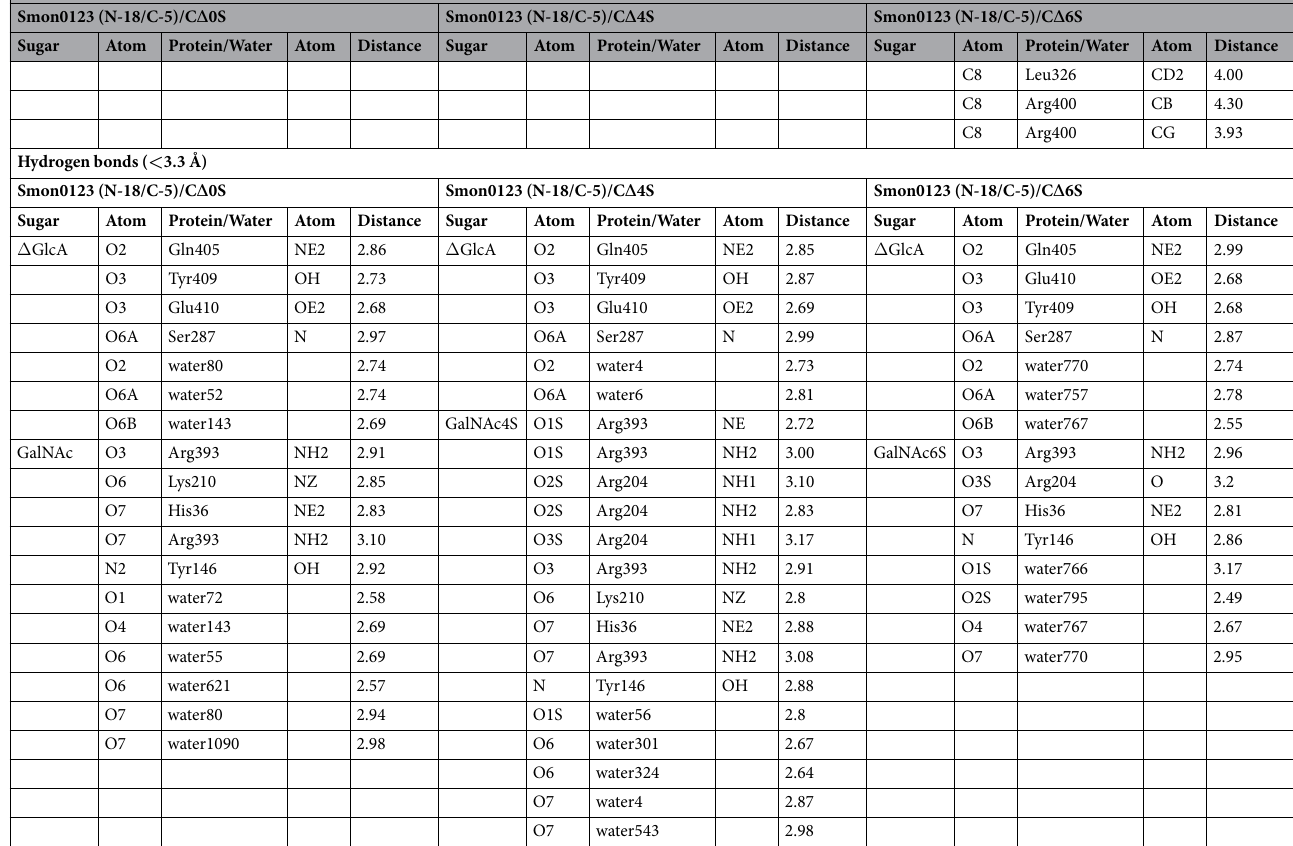
Table 1. Interactions between Smon0123 and unsaturated GAG disaccharides